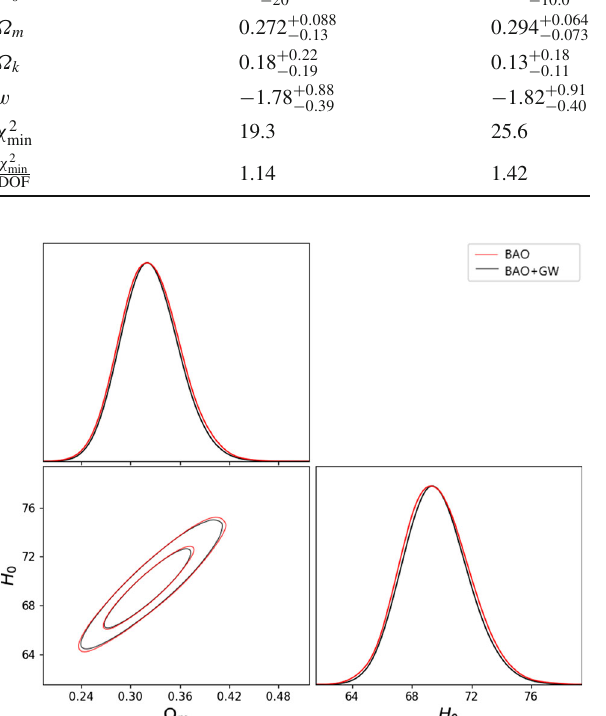
Fig. 1 The 1D PDFs and the 2D contours for the independent param- eters in the Λ CDM model